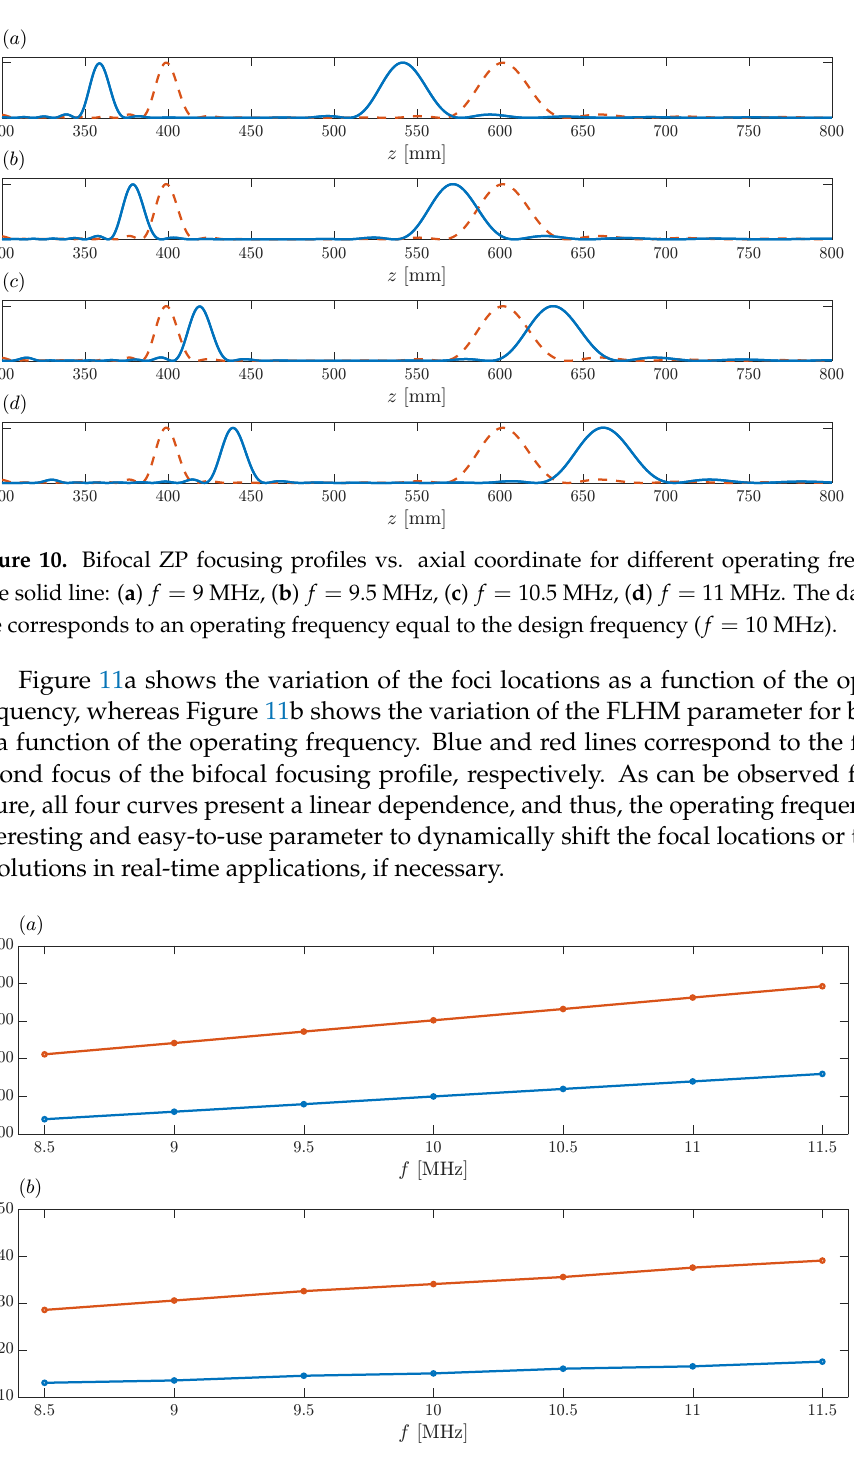
Figure 11. ( a ) Foci location against operating frequency. ( b ) Foci FLHM against operating frequency. Blue and red lines refer to the first and second focus at the bifocal focusing profile,